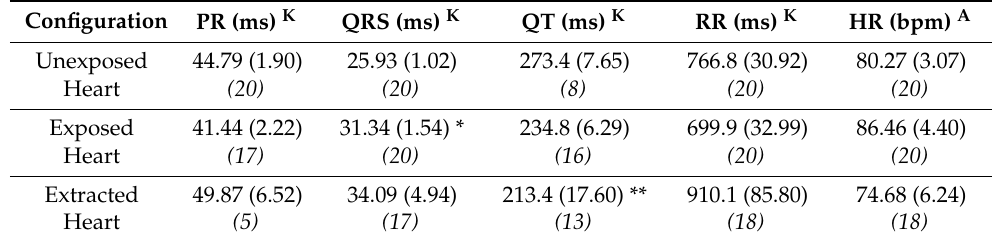
Table 1. The ECG characteristics for each recording configuration. Data are presented as mean (SEM). The sample size ( n ) is indicated in italic in brackets for each parameter. p values were calculated using either a one-way ANOVA( A ) or the Kruskal-Wallis( K ) test. * p < 0.05, ** p < 0.01.